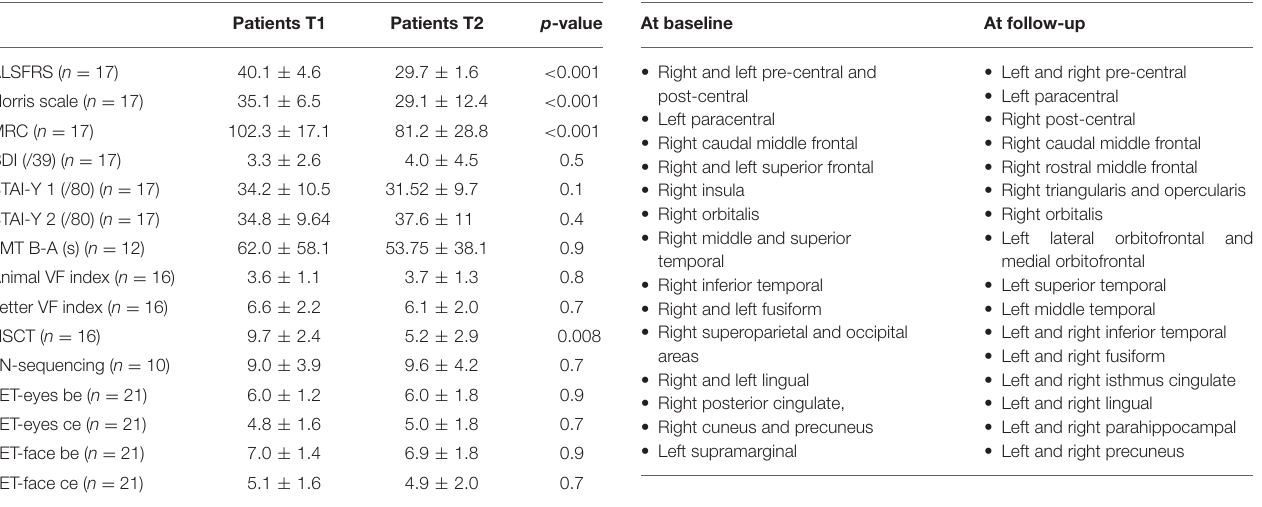
cognitively impaired. All four were already cognitively impaired at baseline. We only found two correlations, both negative: (1) between the Norris and STAI-Y (trait) scores ( r = − 0.6, p = 0.02), meaning that the more bulbar symptoms patients had, the more anxious they were, and (2) between the ALSFRS-R score and the Animal VF index ( r = − 0.4, p = 0.04), meaning that the more neurologically affected patients were, the poorer their verbal fluency performances. Cortical Thickness At Baseline Comparison between patients ( n = 40) and controls ( n = 31) revealed cortical thinning in the regions indicated in Table 4 and Figure 1 . Significant positive correlations were found between scores on the FET-face-ce and CTH in the left caudal middle frontal, left superior frontal, left and rostral middle frontal, left and right pre-central, right pars opercularis and pars triangularis, right superior temporal, right inferior temporal, right lateral occipital and right inferior parietal cortices ( n = 40; Figure 2 ). TMT B- A time correlated significantly and negatively with the CTH in left lateral occipital areas ( n = 37; Figure 2 ). A part of CTH in the right middle temporal and left pre-central gyrus was both correlated with FET-face-ce performances and significantly reduced. No significant correlation was found between CTH and performances on VF, HSCT and LN-sequencing. At Follow-Up In the 17 patients, CTH significantly decreased between baseline and follow-up in the regions summarized in Table 4 and Figure 3 . In nine patients, significant negative correlations were found between TMT B-A time SPC and CTH SPC in the right pre- and post-central gyri, meaning that when cortical thinning increased in these regions, TMT B-A time increased ( Figure 4A